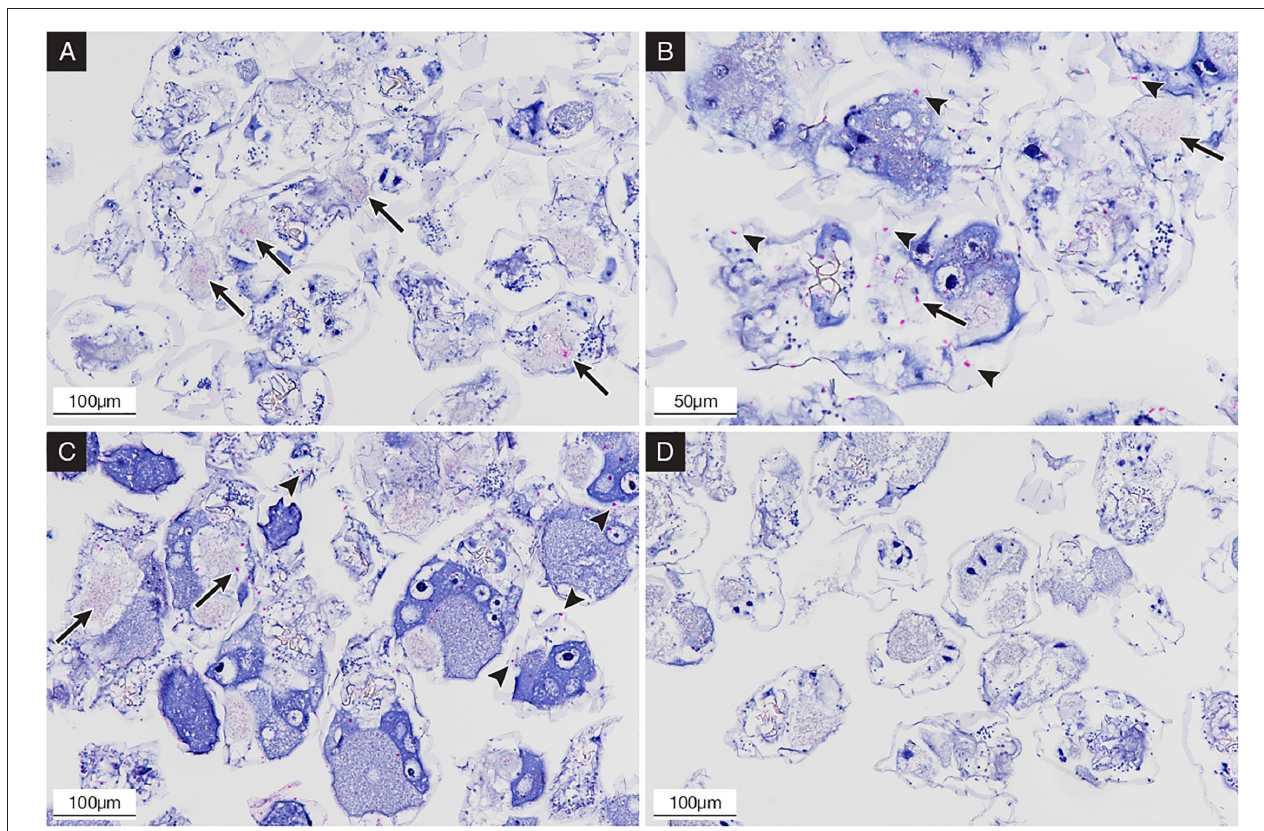
FIGURE 3 | Immunohistochemical (IHC) staining of NNV-exposed rotifers at 6, 24, and 48 hpc; the presence of betanodavirus antigens was revealed in bright red color. (A) 6 hpc; rotifers showing IHC staining in the stomach and intestinal tract (arrows); (B) 24 hpc; rotifers showing IHC staining in the gut content (arrows) and in the pseudocoelom and inner cuticle (arrowheads); (C) 48 hpc; rotifers showing increased IHC staining in pseudocoelom (arrowheads); (D) mock-challenged rotifers after 24h, negative control with no evidence of